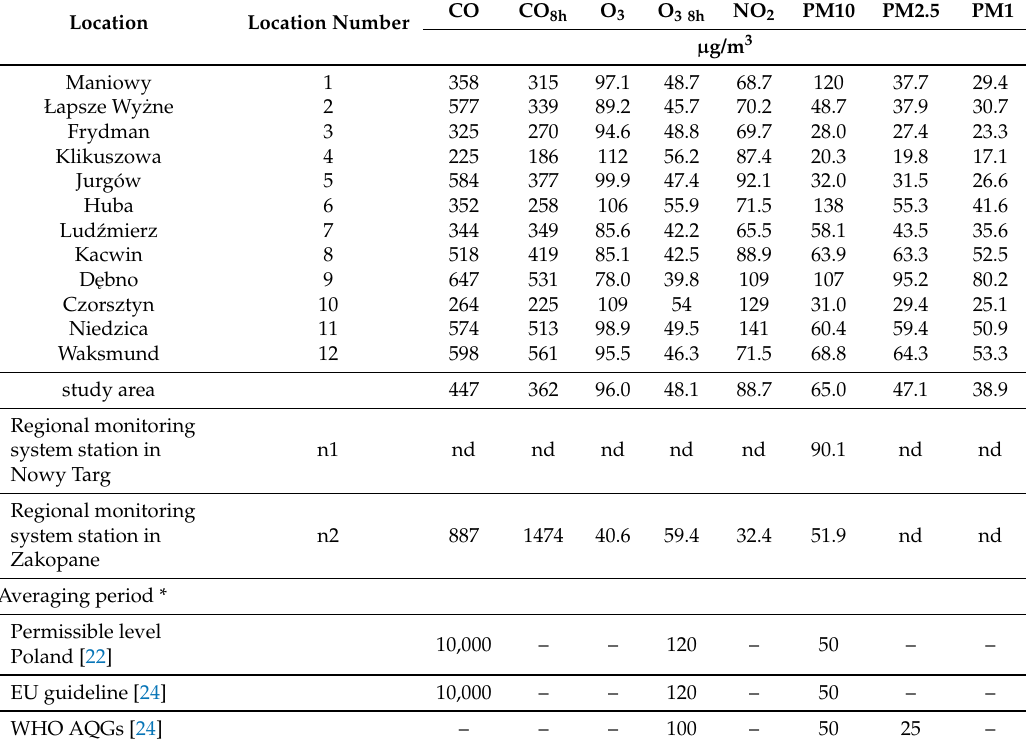
Table 2. Mean 24 h concentrations (unless stated differently) of analysed contaminants in ambient air (nd—not determined; * only 24 h and 8 h permissible levels or guidelines were analysed; –: not applicable to 24 h or 8 h averaging periods; WHO AQGs—World Health Organization air quality